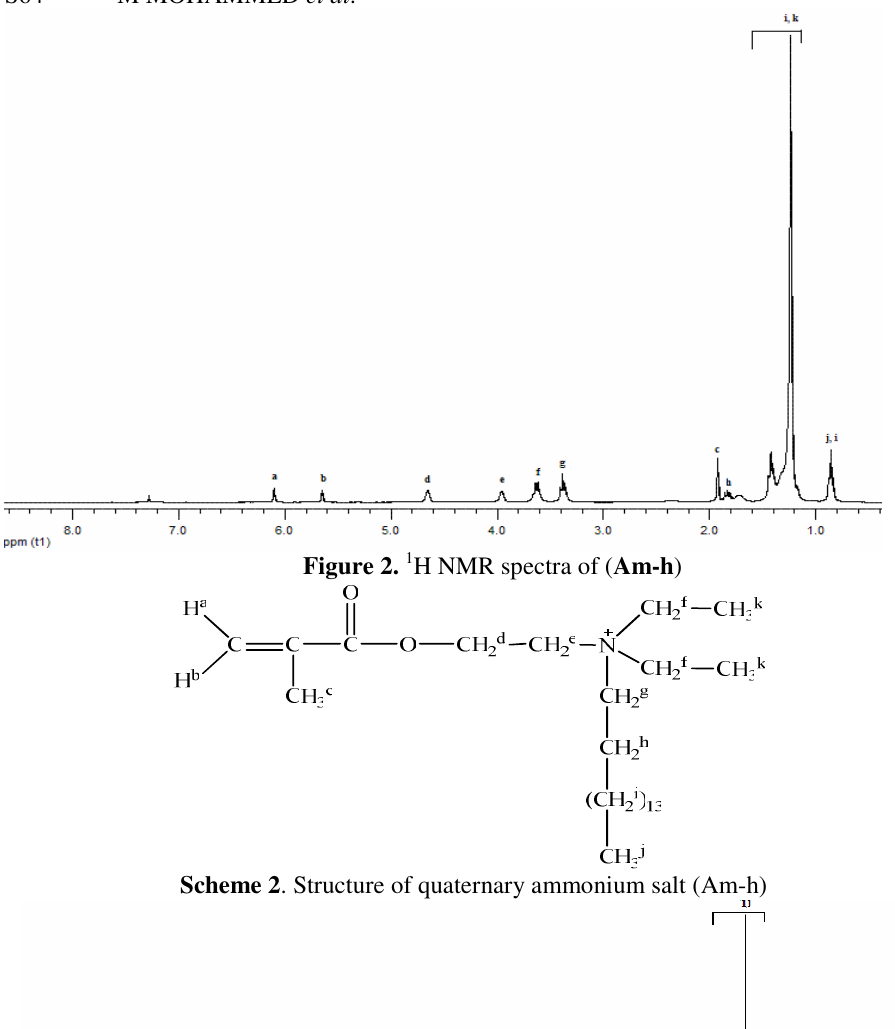
Scheme 2 . Structure of quaternary ammonium salt (Am-h)